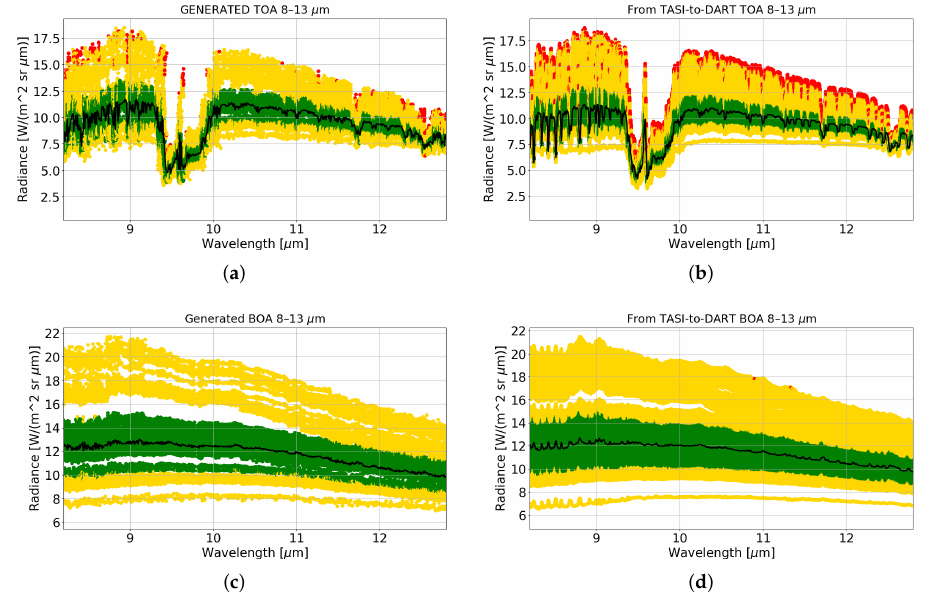
Figure 7. ( a ) TASI2DART-generated TOA radiance box plot. ( b ) TASI-to-DART TOA radiance box plot. ( c ) TASI2DART-generated BOA radiance box plot. ( d ) TASI-to-DART BOA radiance box plot. See Figure 5 for